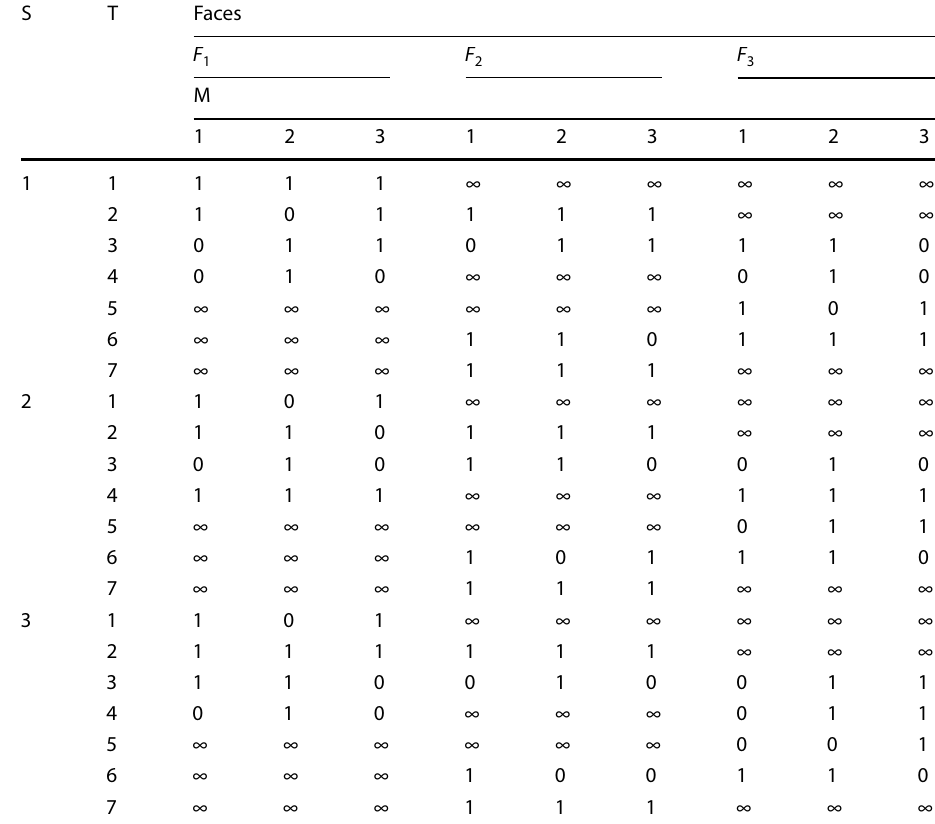
Table 6 Scheduling the activation of a sensor i for each face f of a mission